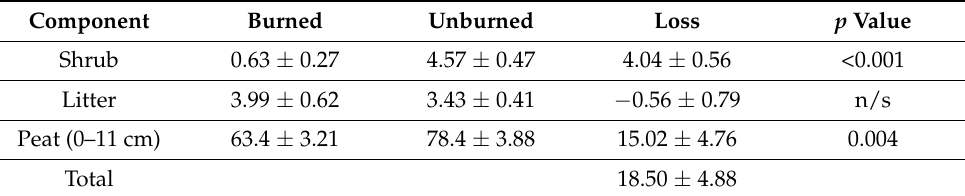
Table 4. Mass of above- and belowground carbon and carbon loss (Mg C ha − 1 ) across two sites in degraded peatlands of Central Kalimantan. Component